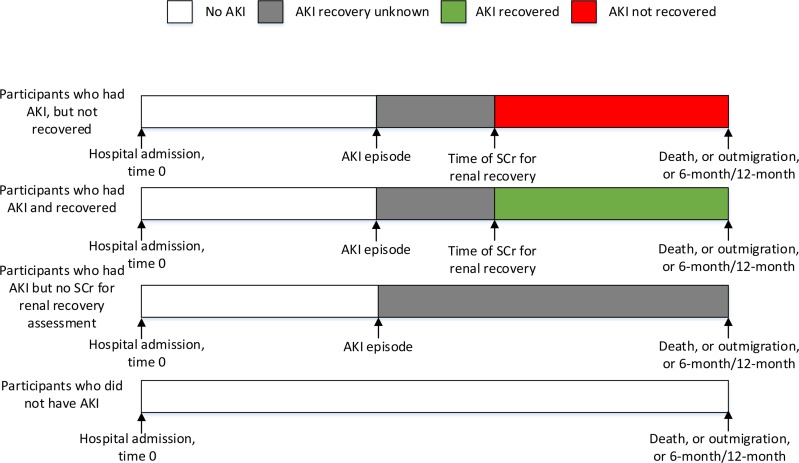
Timeline of exposure status updated by AKI episodes and renal recovery.Time of an AKI episode is the time of peak in-hospital SCr met AKI criteria during hospitalization. Time of SCr for AKI recovery is the time of closet SCr to 30 days post an AKI episode.